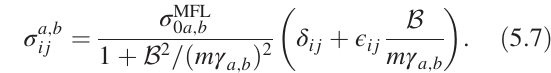
¼ 0 . 8 and γ ¼ 0 . 8 . The dimensionless magnetic field B is =E F = γ b a a b . The orange ( B ) curve is evaluated at T ¼ 1 . 0 and a;b ¼ 0 . 1 T . The curves are slightly offset for visualization, but actually a